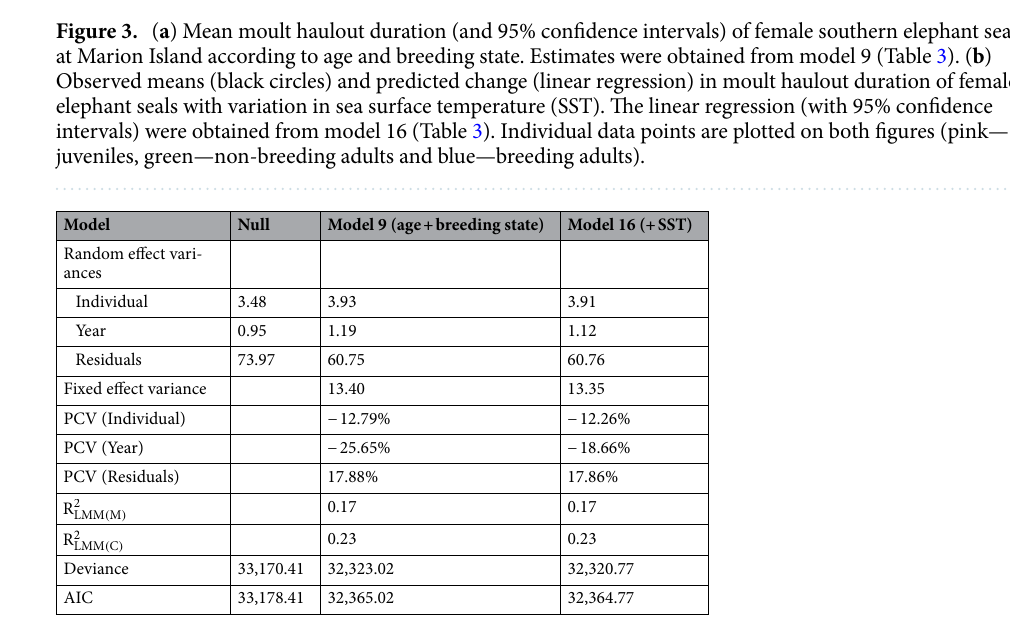
Table 4. Variance partitioning of selected linear mixed-effects models of variation in moult haulout duration of female southern elephant seals at Marion Island (1986–2018). Model terms are as in Table